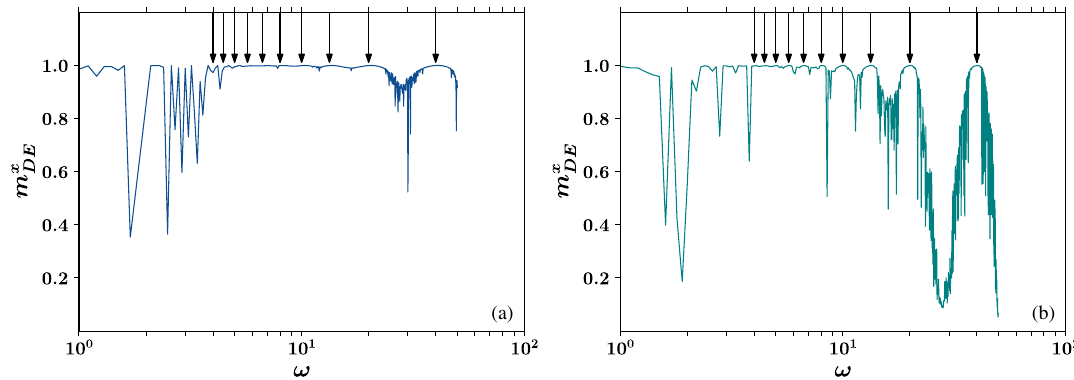
FIG. 7. Infinite-time limit of the magnetization, m x , versus driving frequency ω for Heisenberg interactions. (a) For the DE x ð HB Þ Hamiltonian in [Eq. (6)], with V replaced by V HB [Eq. (47)] and H x 0 by H 0 [Eq. (48)], with translationally invariant isotropic interaction strengths ( J x i ¼ J y i ¼ J z i ¼ 1 . 0 ). (b) Same model as in the left panel, but with anisotropic interaction